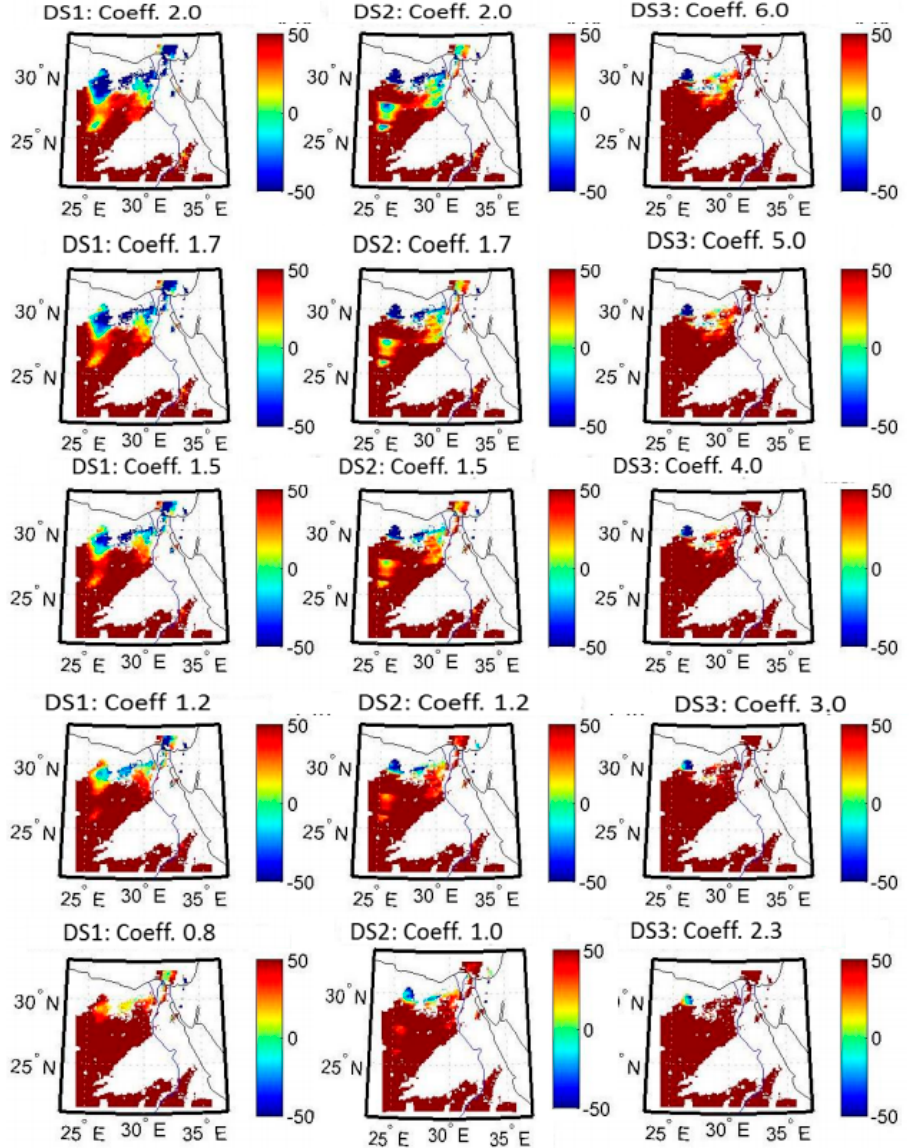
Figure 7. The distribution of spatial error in (%) between MODIS (as reference) and the Model AOD using fifteen simulations for the January 2004 dust storm (panel arrangement is the same as shown in Figure 2).